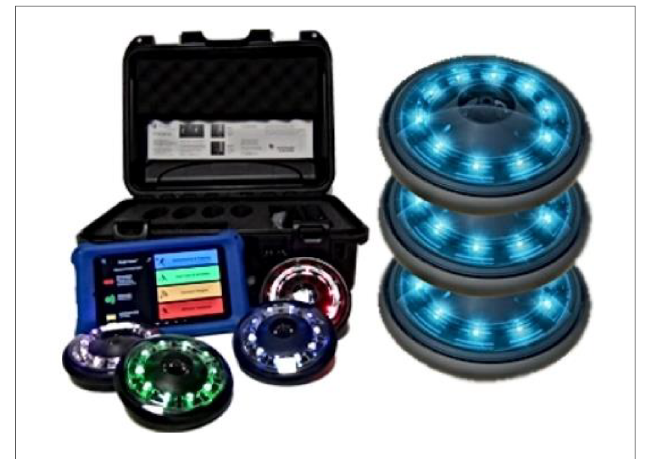
FIGURE 1 The FIT LIGHT training system of small-sided games with and without basketball.